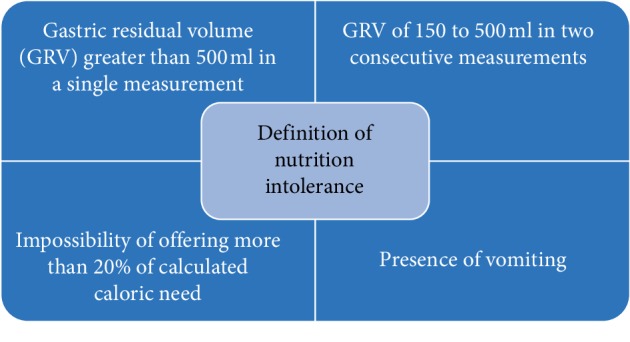
Definition of nutrition intolerance commonly used in the literature.